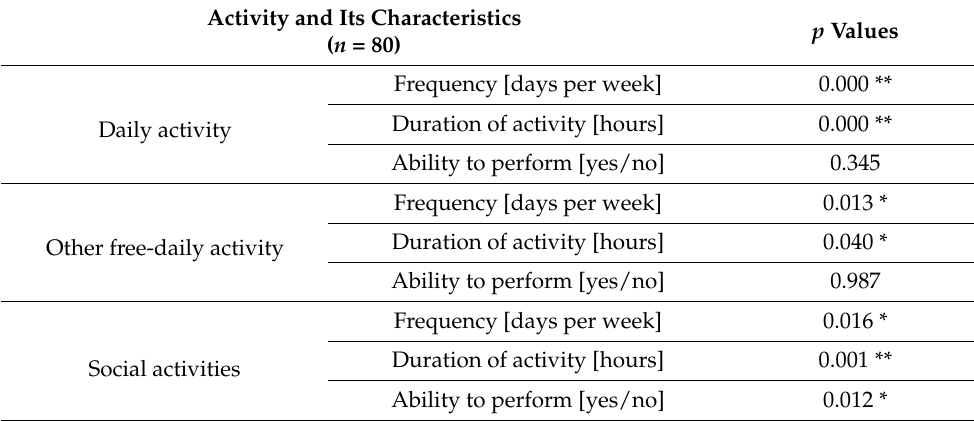
Table 4. Participation in different activities in the period before and six months after COVID-19 among the study population. Statistical significance was obtained using the Chi-square test (X 2 ). Asterisks (*) represent the statistically significant difference in selected characteristic of activity before and six months after COVID-19, and the double asterisk (**) represents high significance